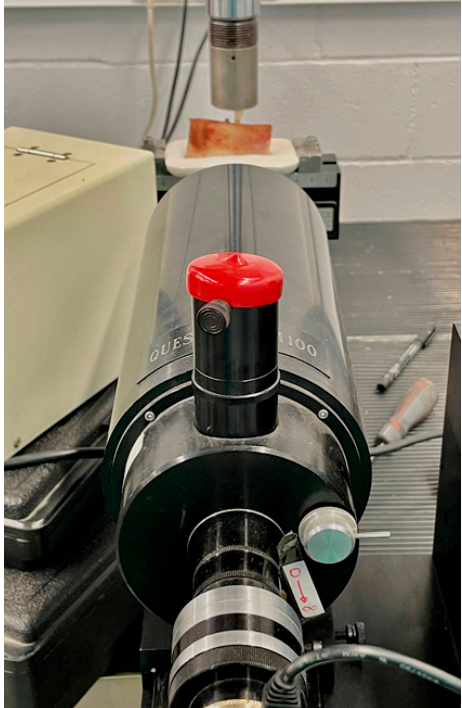
Figure 4. Questar QM-100 long-distance microscope focused on one of the implants in the sample. In the background you can see a rib mounted on its plaster base and mechanized on the base of the load creep machine.